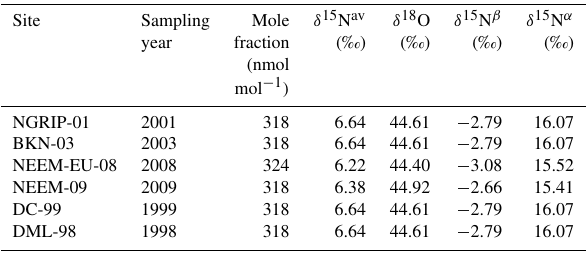
Table 2. Detailed information on the mole fraction and the isotopic composition of the laboratory reference gases used for correcting each set of firn air